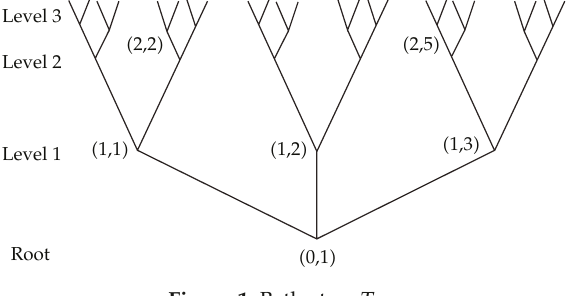
Figure 1: Bethe tree T B, 2